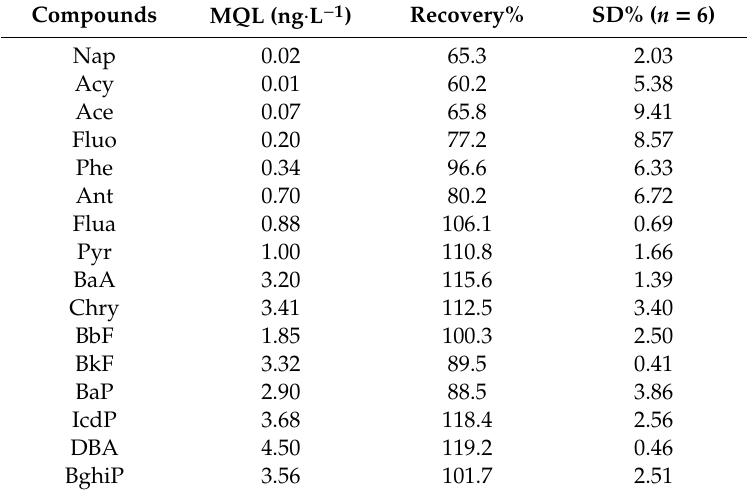
Table 1. Quality control